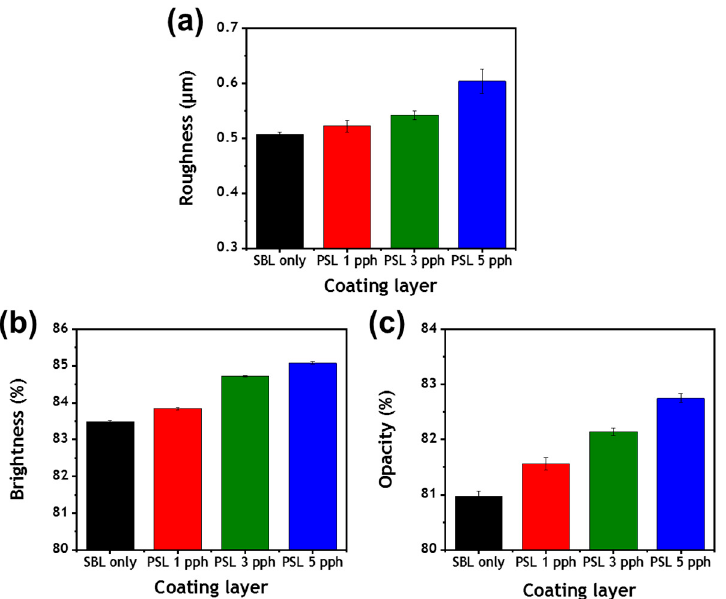
Figure 6. Surface and optical properties of coating layers containing various amounts of the PS latex cobinder: ( a ) roughness, ( b ) brightness, and ( c ) opacity of the coating layers.